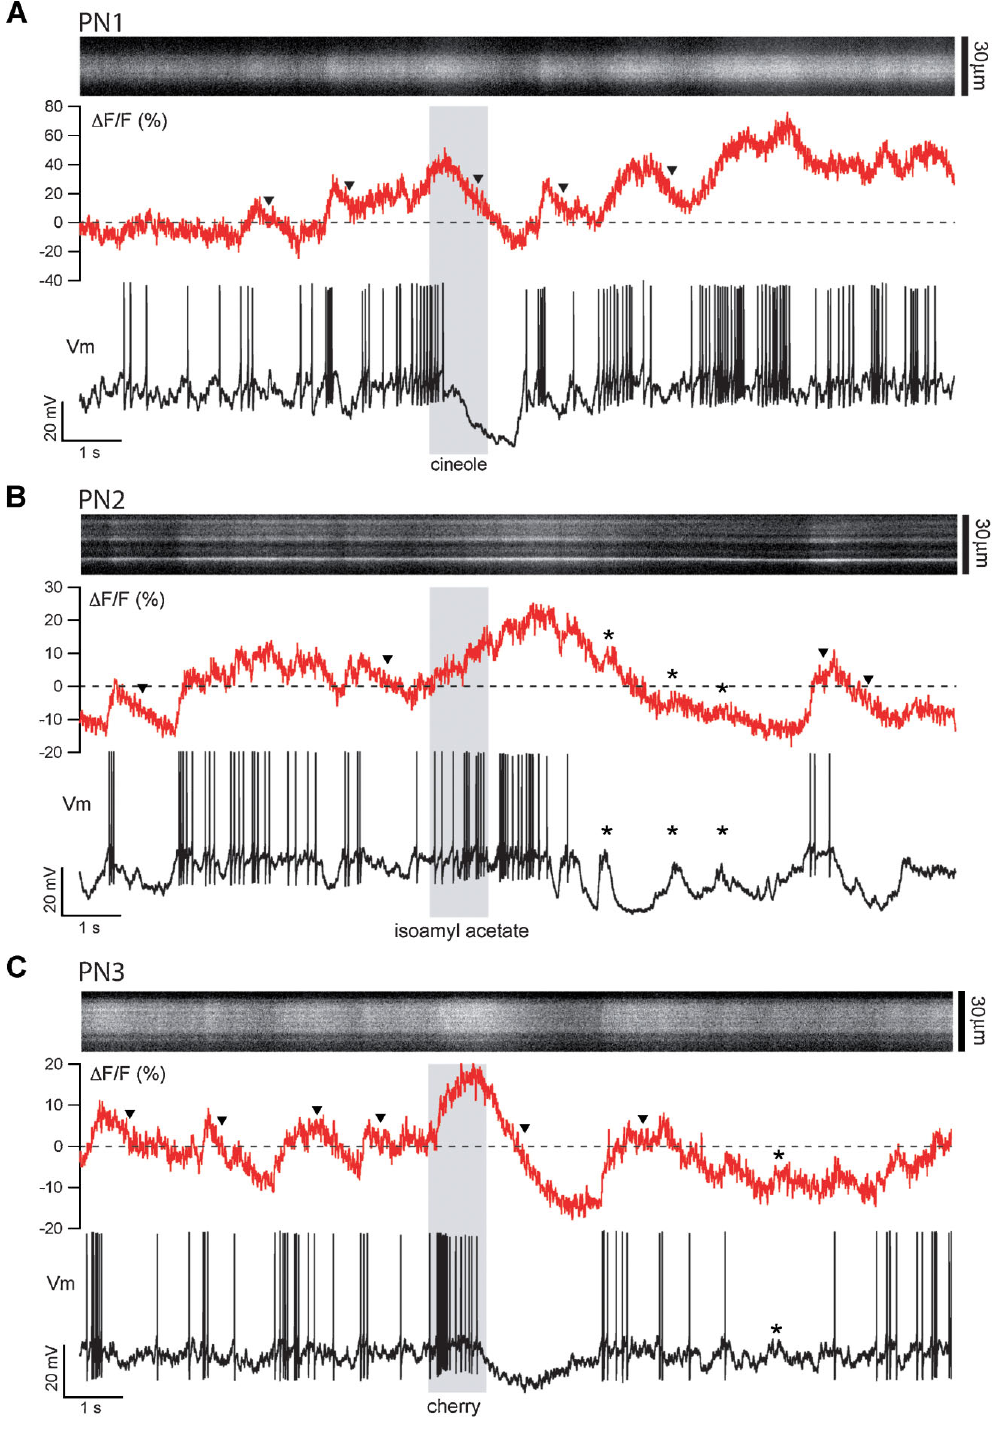
Figure 2. Simultaneous glomerular-calcium imaging and dendritic recording in PNs in vivo . ( A – C ) Single 24second-long trials (16seconds shown), each with a different PN and odor stimulus (indicated by vertical gray band). Top: xt-scan across one glomerular tuft (30 (cid:1) m × 16seconds); middle: corresponding (cid:3) F/F (500-Hz sampling); bottom: intracellular membrane potential (V m ; 15kHz sampling). Stippled line: average baseline fluorescence before odor pulse. Note subthreshold components of PN voltage and corresponding ∆ F/F deflections (asterisks), and non-exponential decay of ∆ F/F after cessation of firing